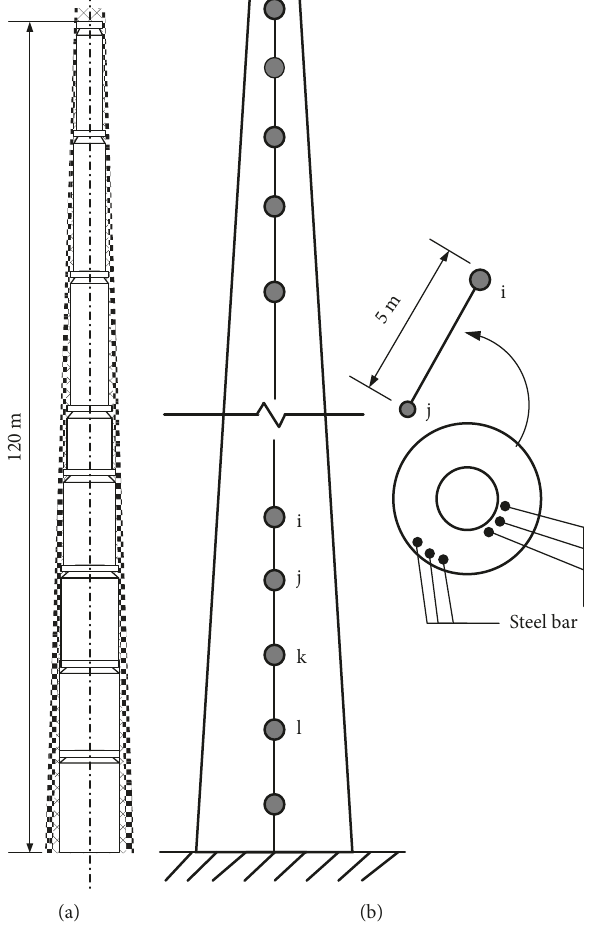
Figure 2: Elevation view of the chimney model: (a) geometry model; (b) finite element model.